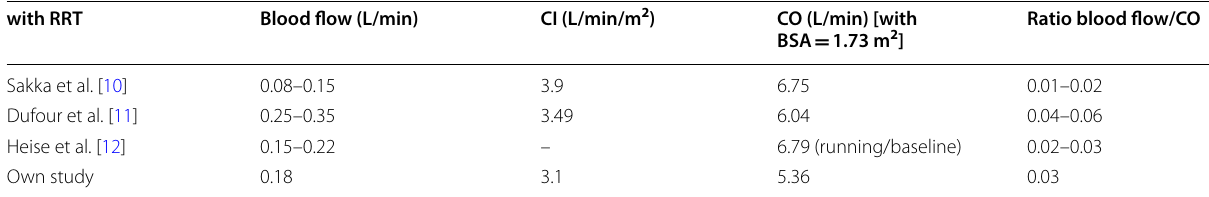
Table 5 Calculation of the ratio between the blood flow and CO with RRT Blood flow